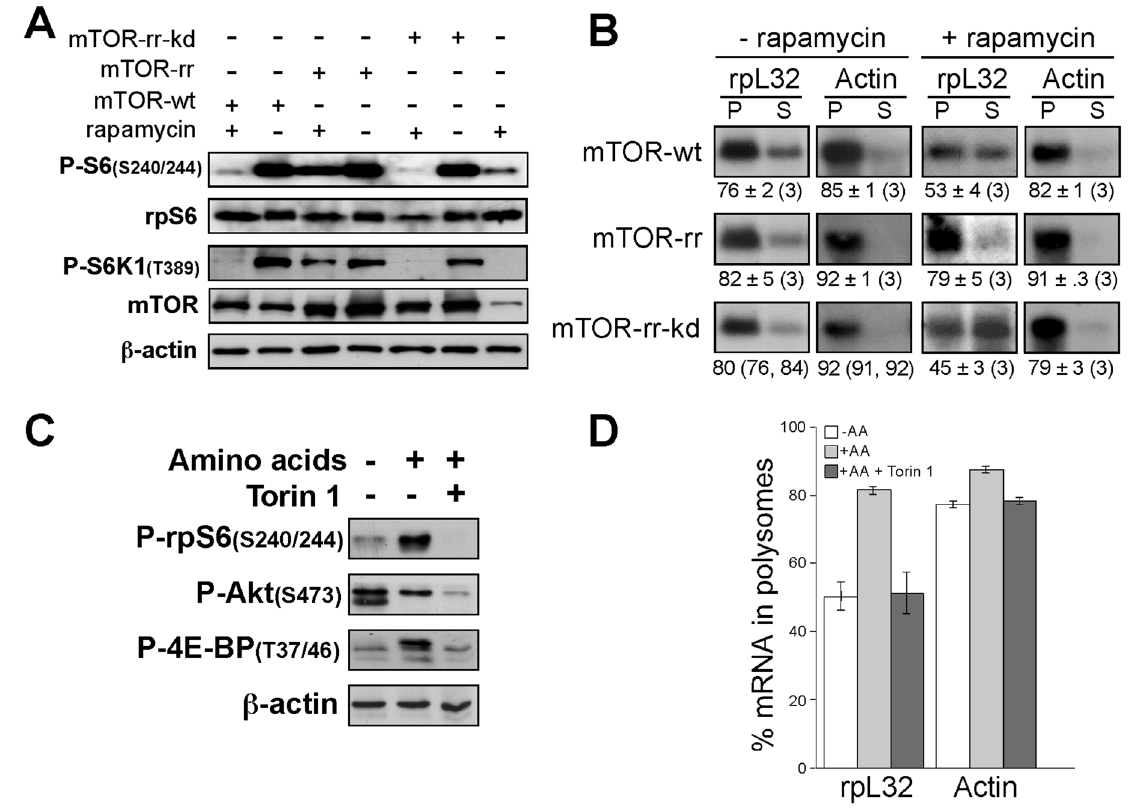
Figure 4. The kinase activity of mTOR is essential for translational control of TOP mRNAs. (A) HEK293 cells were transfected with vectors expressing mTOR-wt, mTOR-rr or mTOR-rr-kd, two days later the cells were amino acid-starved for 3 h followed by 3 h refeeding without or with 20 nM rapamycin. Cytoplasmic proteins derived from the cells were subjected to Western blot analysis with the indicated antibodies. B) Cytoplasmic extracts derived from cells treated as described in (A), were subjected to polysomal analysis. C) HEK293 cells were amino acid-starved for 3 h, or amino acid-starved for 3 h followed by 3 h refeeding without or with 50 nM Torin1. Cytoplasmic proteins derived from the cells were subjected to Western blot analysis with the indicated antibodies. D) Cytoplasmic extracts derived from cells treated as described in (C) were subjected to polysomal analysis and the percentage of mRNA in polysomes is presented as an average 6 SEM of three experiments.